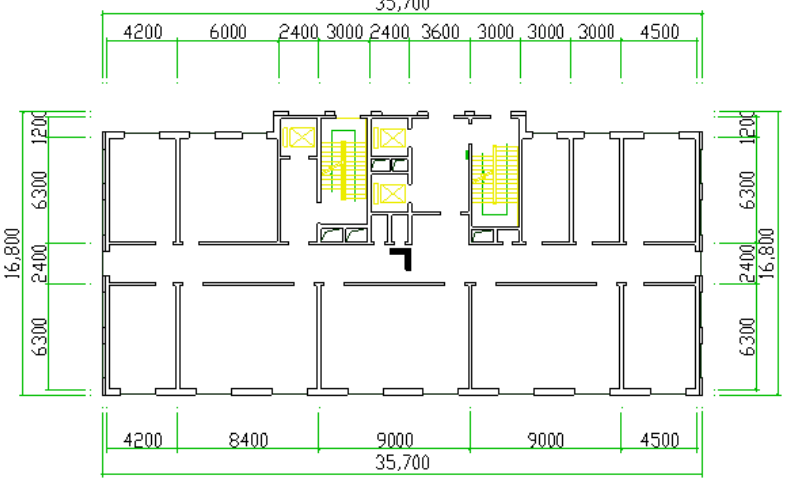
Figure 1. Plan of a typical floor (The black block is the sensor position; unit: